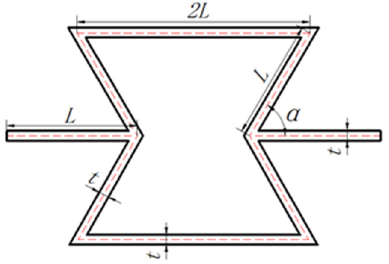
Figure 2. Structural parameters of the traditional re-entrant honeycomb (2 L is the length of upper and lower cell walls, L is the length of the ligament, α is the angle between the cell walls and t is the thickness of cell wall.).